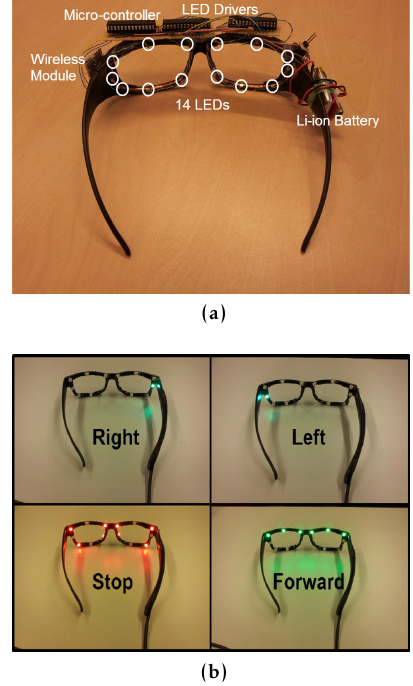
Figure 1. (a): Second constructed prototype; white circles depict the position of LED indicators implanted on the frame of the eyeglasses. (b): Lightweight and user friendly design of the